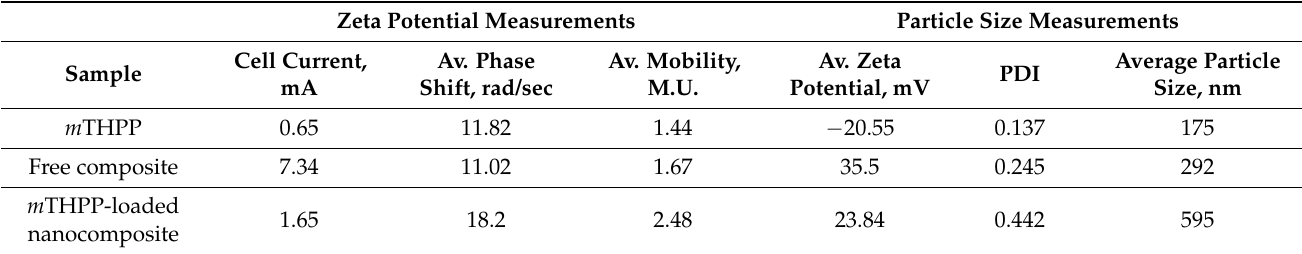
Table 1. Zeta potential measurements of m THPP, the m THPP-loaded nanocomposite, and the free nanocomposite.